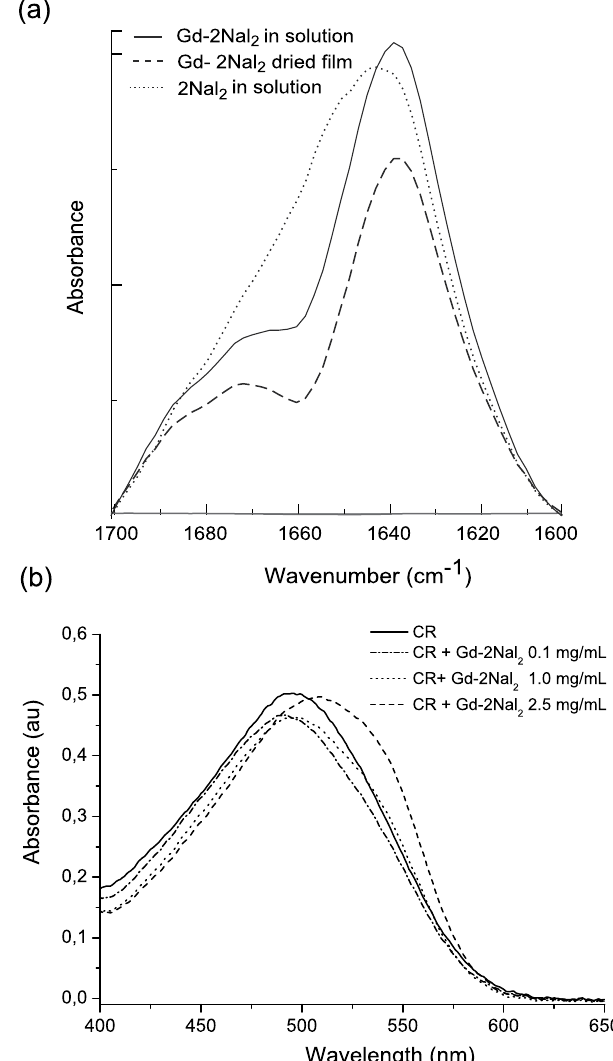
Figure 3. ( a ) FTIR spectra of 2Nal 2 and Gd-2Nal 2 in the amide I region at 5.0 mg/mL. ( b ) UV-Vis spectra of 2Nal 2 and Gd-2Nal 2 , stained with Congo Red at 0.1 and 1.0 mg/mL. The spectrum of Congo Red is also reported for